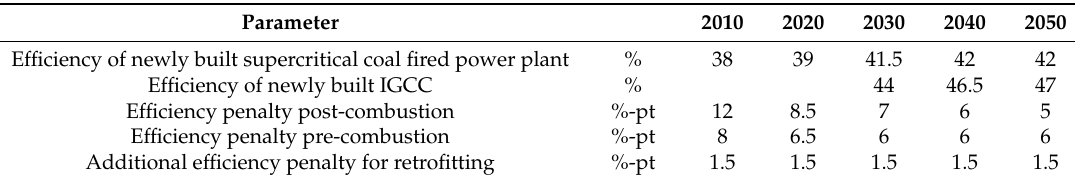
Table 3. Efficiencies and efficiency losses through CCS assumed for future newly built coal-fired power plants in South Africa.